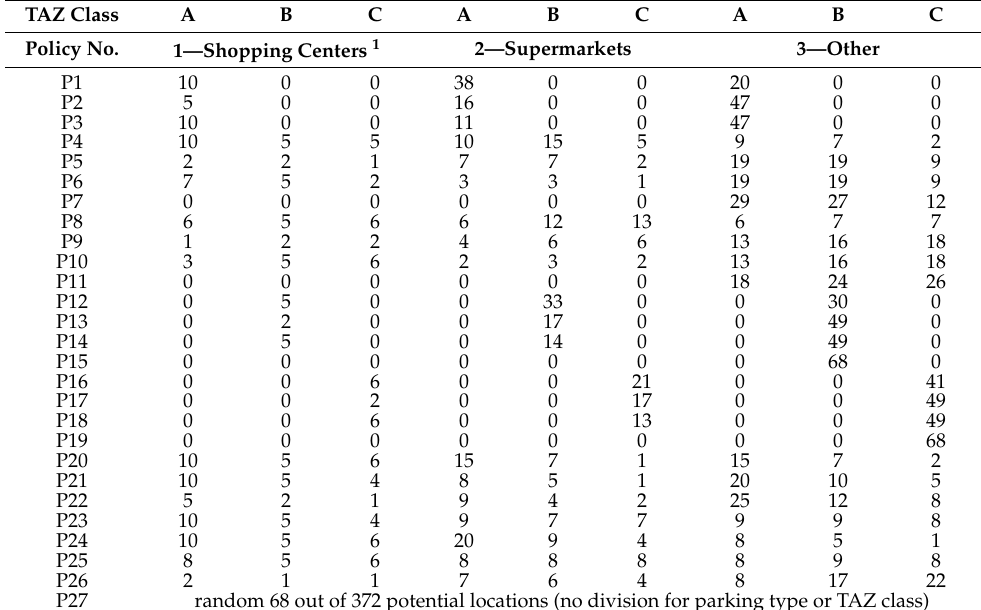
Table A2. Parameters describing draw policies—the quantities of parking lots drawn in each of the